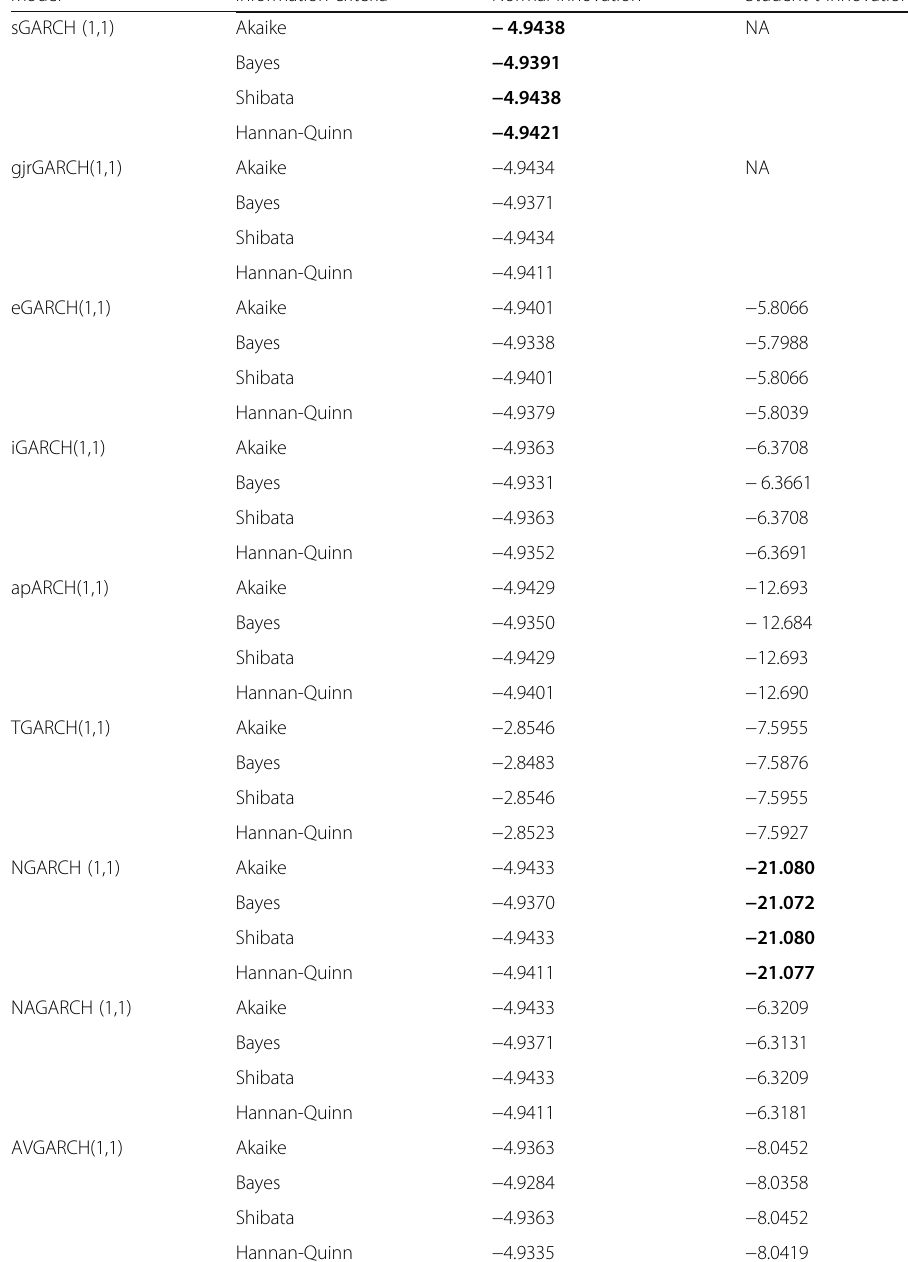
Table 5 GARCH models and their performance on the cleansed log returns of daily stock price of Total Nigeria